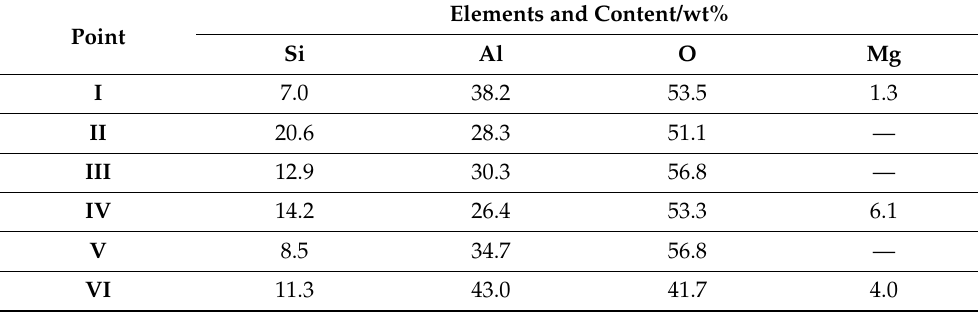
Table 3. EDS analysis.